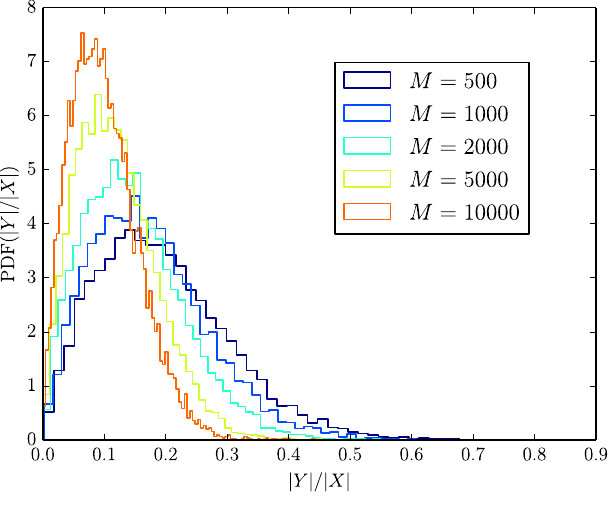
.FIG. 22. The same as in Fig. 20 but for γ ¼ 1 . 6